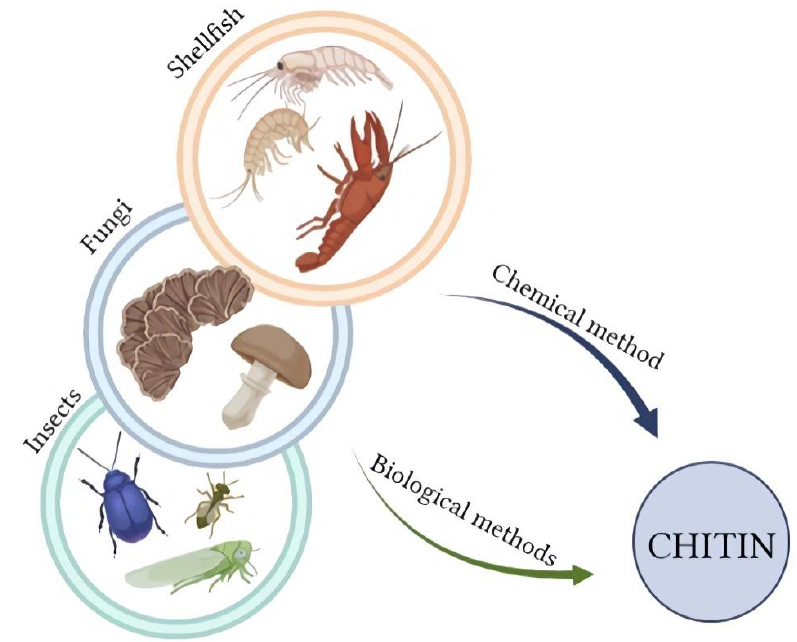
Figure 3. The sources of chitin for chitosan preparation (Created with BioRender.com; accessed on 4 January 2023).